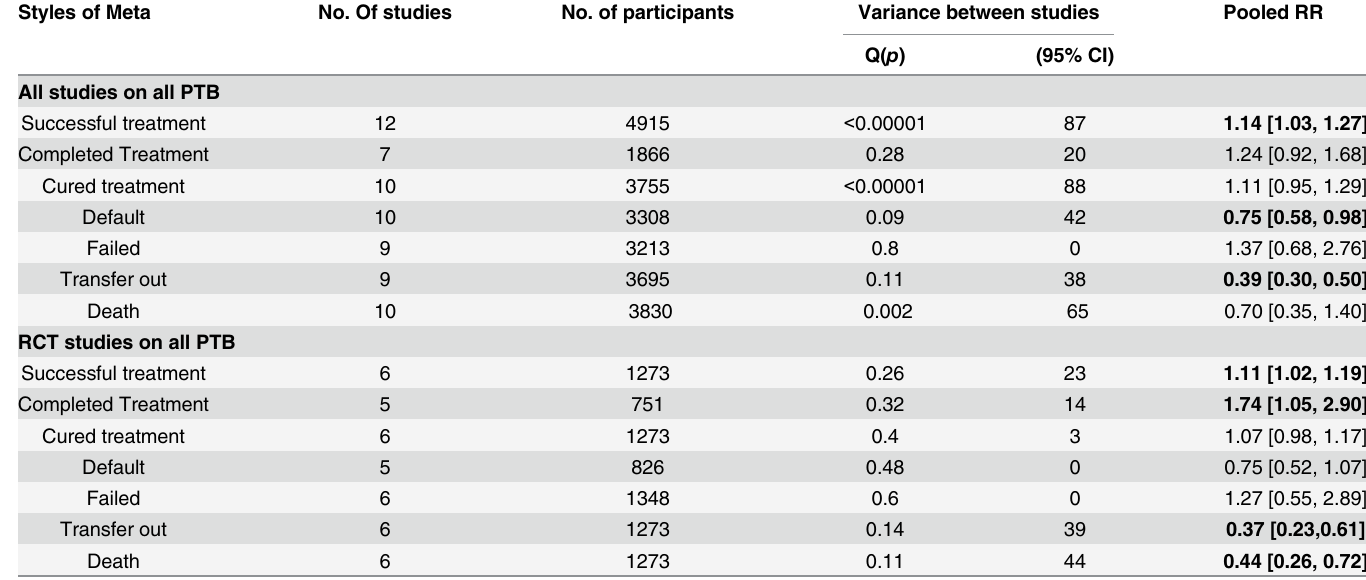
Table 2. Results of meta-analysis of the studies on comparison between CB-DOT and Clinic-based DOT in TB control. Styles of Meta No. Of studies No. of participants Variance between studies Pooled RR